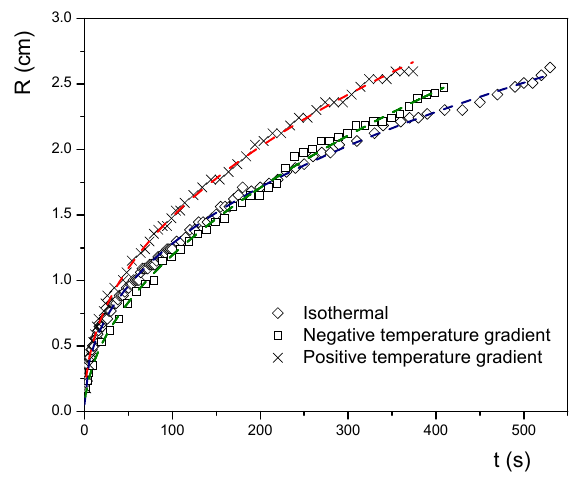
Figure 3. Dimensional plot of the time evolution of the experimental imbibition fronts (symbols) for positive and negative gradients and for the isotherm case where T 0 = T 1 = 301.2 K (28 ◦ C). Dashed curves correspond to the respective numerical solutions: red dashed line for case G > 0, green dashed line for G < 0, and blue dashed line for G = 0. Symbol sizes correspond to the standard deviation of 5%.